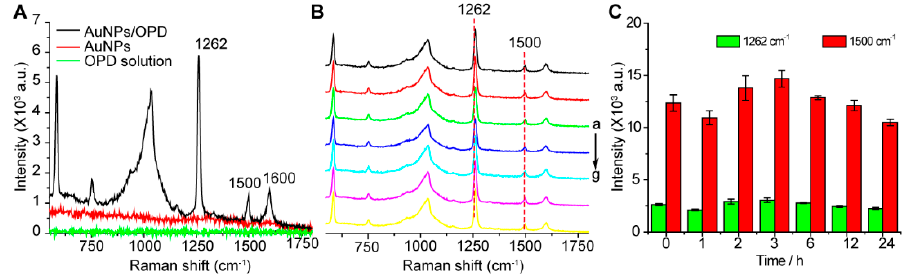
Figure 2. ( A ) SERS spectra of the AuNPs/OPD, AuNPs and OPD solutions; ( B ) Raman response of the AuNPs/OPD solution under incubation at 37 °C for (a) 0 h, (b) 1 h, (c) 2 h, (d) 3 h, (e) 6 h, (f) 12 h, (g) 24 h; ( C ) SERS intensities at the bands of 1500 cm − 1 and 1262 cm − 1 plotted with different incubation times. Error bars were based on three independent measurements.